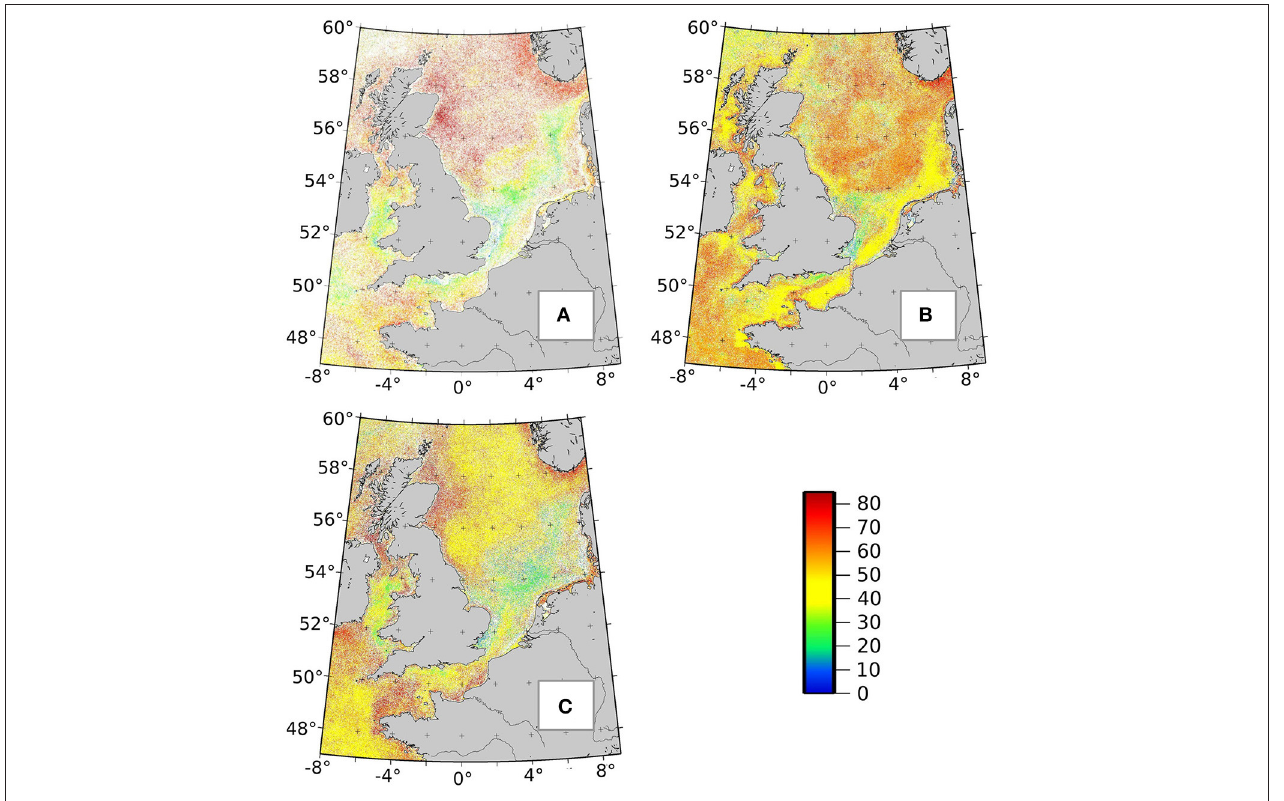
FIGURE 9 | Maps of most frequently detected radiance anomalies classes in the North Sea in March (A) , June (B) , and October (C) . The color bar displays the 85 different Ra( λ ) classes (0–85). The color corresponds to the Ra( λ ) class (identify by a number) with the highest frequency in a specific pixel and month.